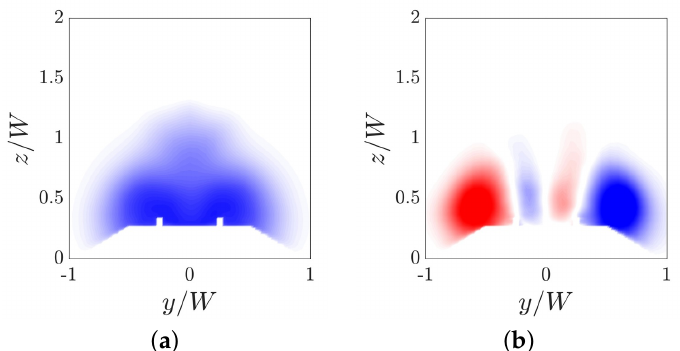
Figure 3. POD (proper orthogonal decomposition) breakdown of slipstream velocity showing ( a ) the shape of the mean and ( b ) the highest order mode or mode 1 for the baseline train case at a downstream distance of 3 L Ref .